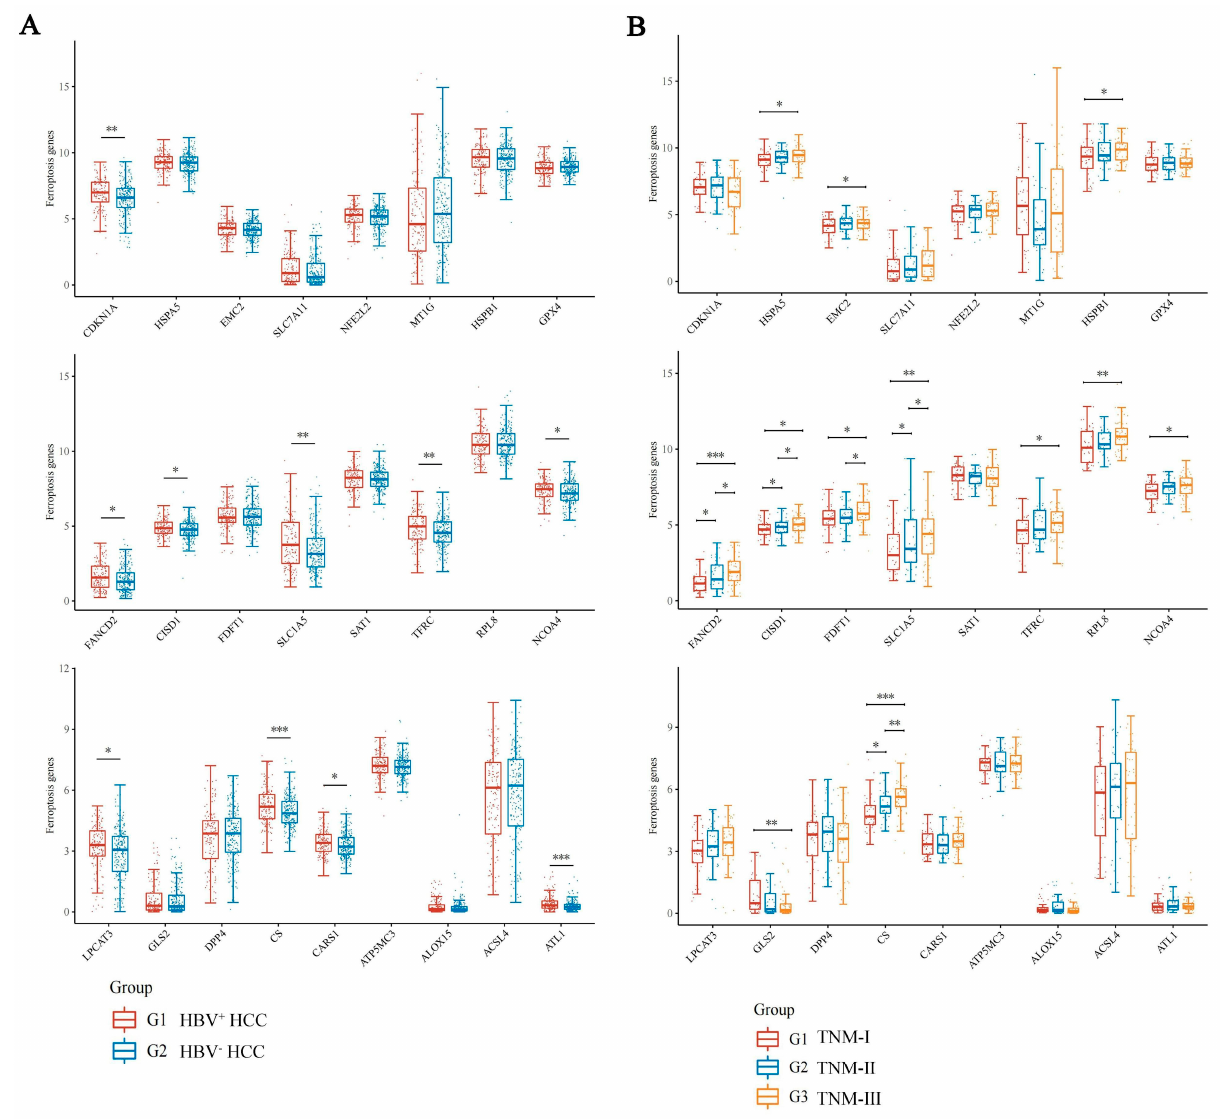
Figure 1. Expression distribution of ferroptosis-related gene mRNA in HCC tissues. The x -axis represents different ferroptosis related genes, and the y -axis represents gene expression distribution. Different colors represent different groups. ( A ) Expression distribution of ferroptosis related gene mRNA in HBV-positive HCC (red) and the HBV-negative HCC (blue). ( B ) The expression distribution of ferroptosis-related gene mRNA in HBV-related HCC with TNM I (red), II (blue) and III (yellow). * p < 0.05, ** p < 0.01, *** p < 0.001. The statistical difference between two groups was compared through the Wilcox test, significance difference of three groups was tested with Kruskal–Wallis